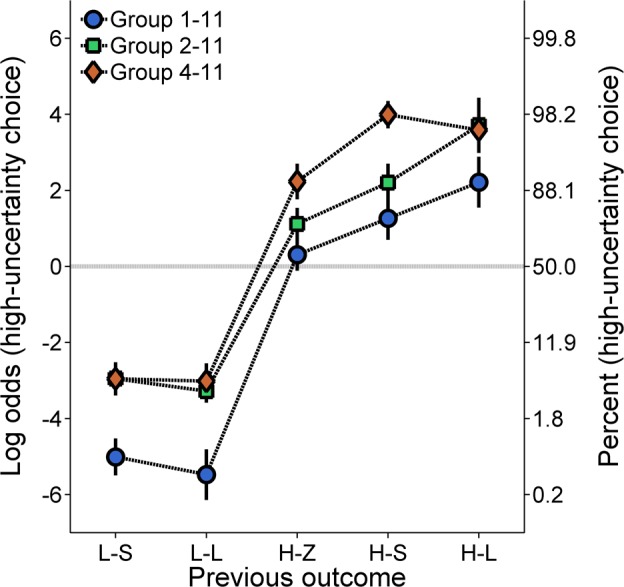
Mean (±SEM) log odds of high-uncertainty choices for each group in Experiment 1 as a function of the outcome of the previous choice, collapsed across the probability of high-uncertainty food delivery.A second ordinate showing percentages corresponding to the log odds values was included to aid interpretation. L-S = low-uncertainty-small; L-L = low-uncertainty-large; H-Z = high-uncertainty-zero; H-S = high-uncertainty-small; H-L = high-uncertainty-large.